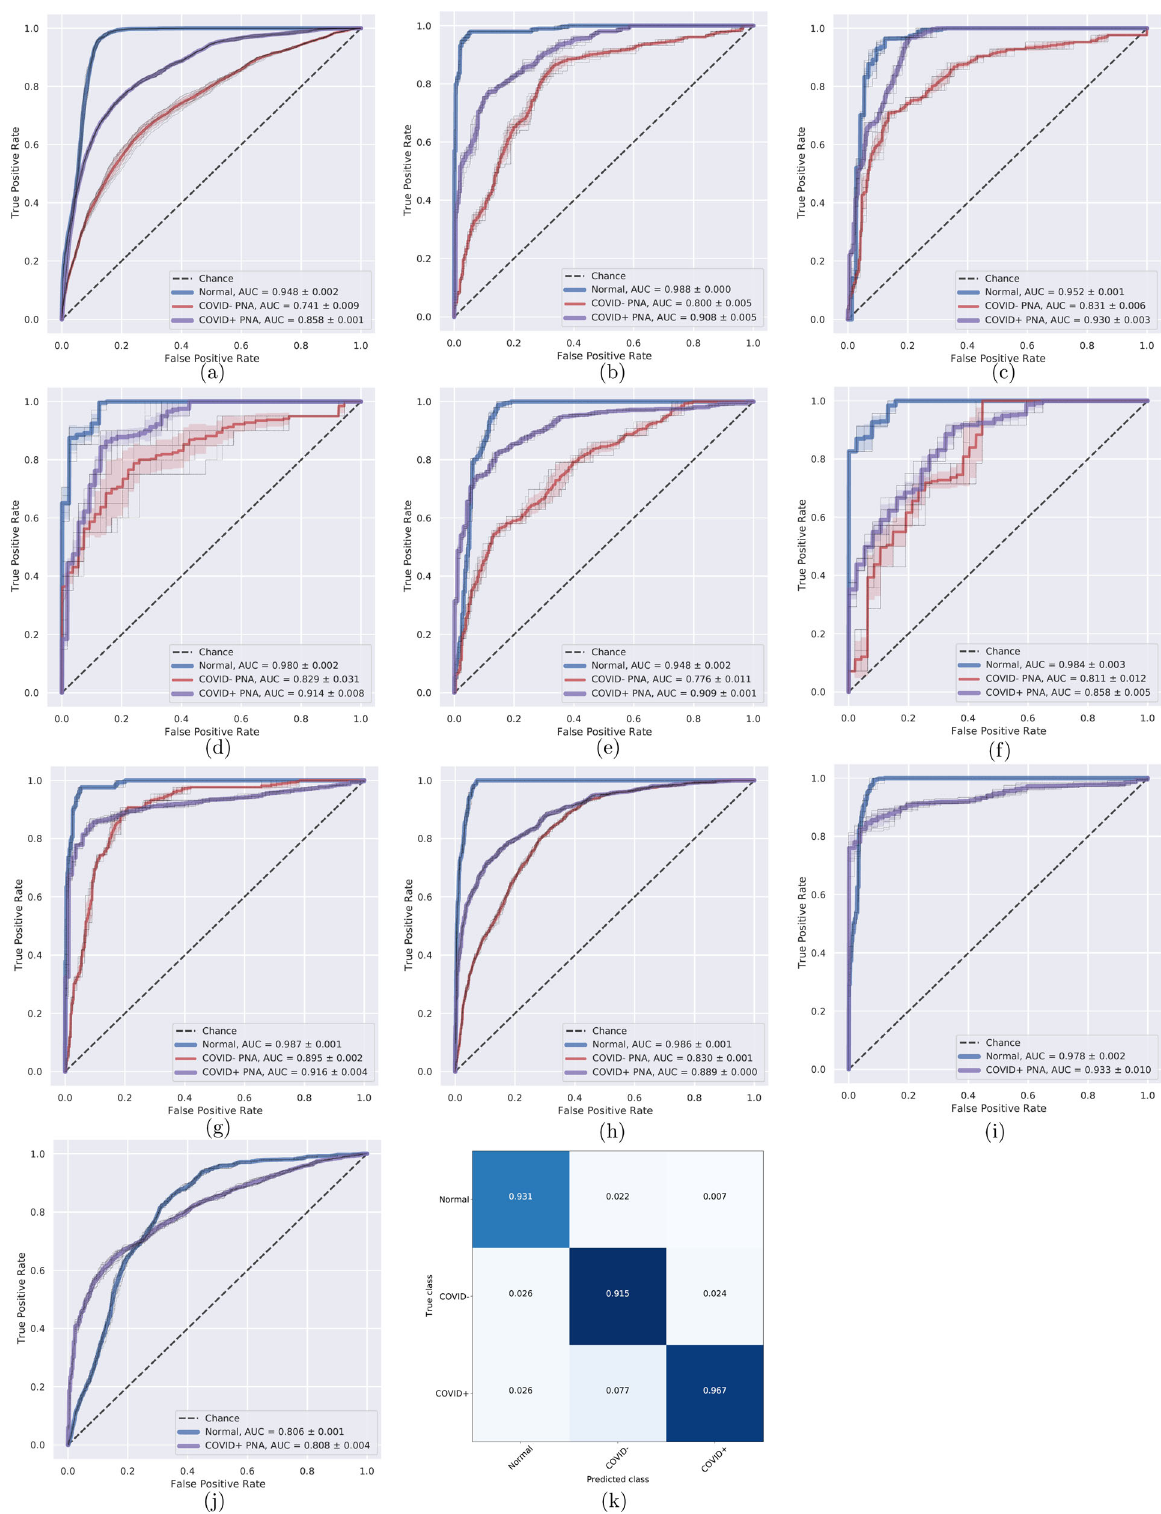
Fig. 3 Receiver operating characteristics (ROC) curves and area under the curve (AUC) for different external test sites. The sites are: China- 1 ( a ), China-2 ( b ), Stanford ( c ), Unity Health ( d ), Koç ( e ), Rajaie ( f ), UNIFESP ( g ), Henry Ford ( h ), TUMS-1 ( i ), MosMedData ( j ). ROC curves were not plotted for sites with imbalanced data: Kyungpook, GUMS, and TUMS-2. The confusion matrix for our model trained on all sites and fi netuned on 20% of site China-1 (15% train, 5% validation) and evaluated on the remaining 80% of China-1 ( k